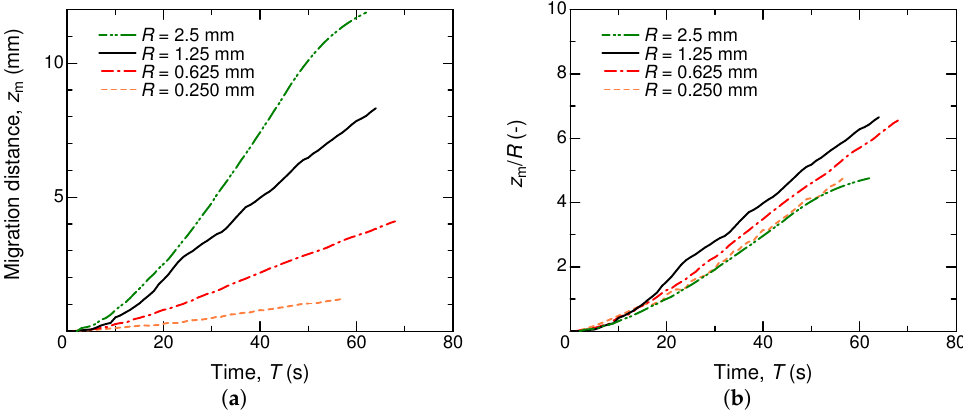
Figure 7. Time series of the migration distance of the liquid column for different tube radii in units of millimeter ( a ). In ( b ), the migration distance is normalized by the tube radius. With L c = 20 mm, N z = 512, and N r =